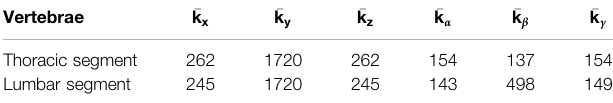
TABLE 2 | Joint stiffness values (in kN/m for translation, N/rad for rotation) for the biomechanical model of the deformation function.